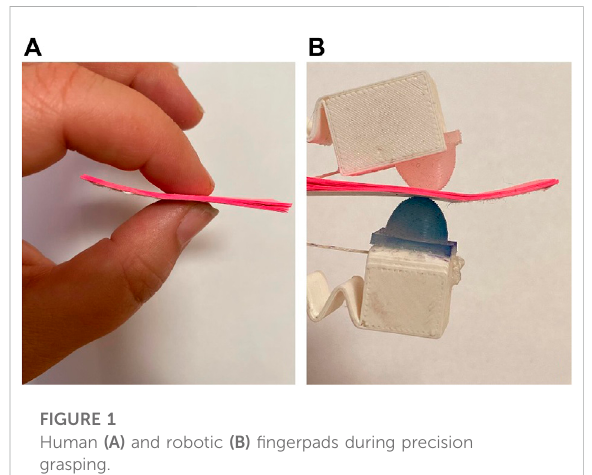
FIGURE 1 Human (A) and robotic (B) fi ngerpads during precision